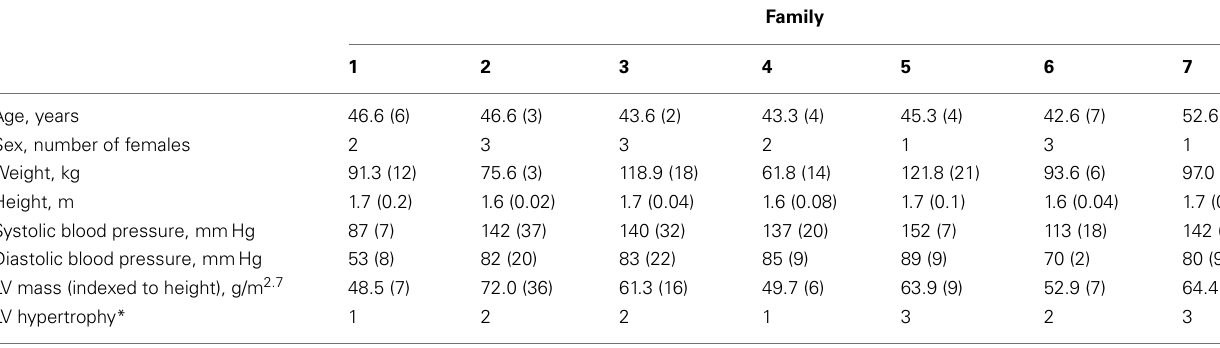
Table 1 | Phenotypic values for seven hypertensiveAfrican-American sibling